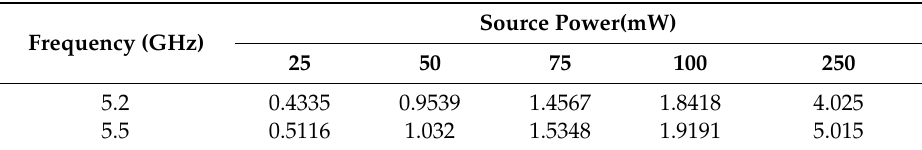
Table 4. SAR values for di ff erent source power.